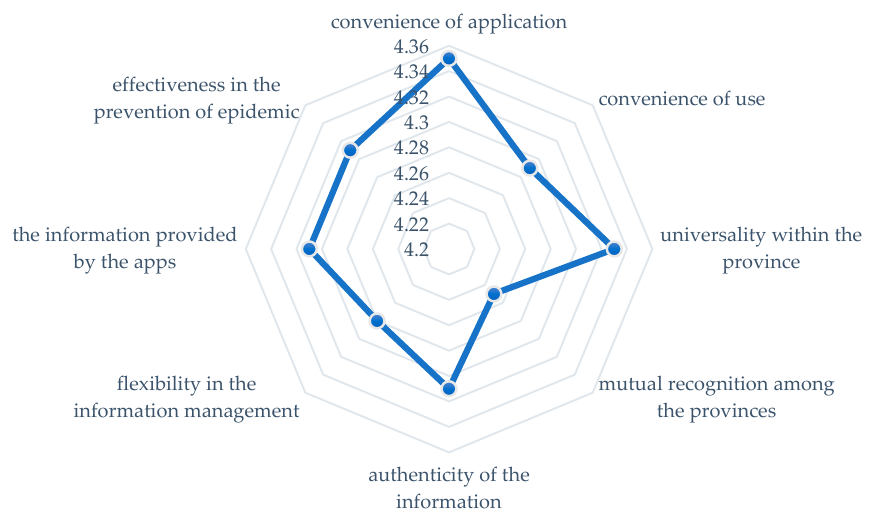
Figure 4. Public evaluation of health code apps (5-point